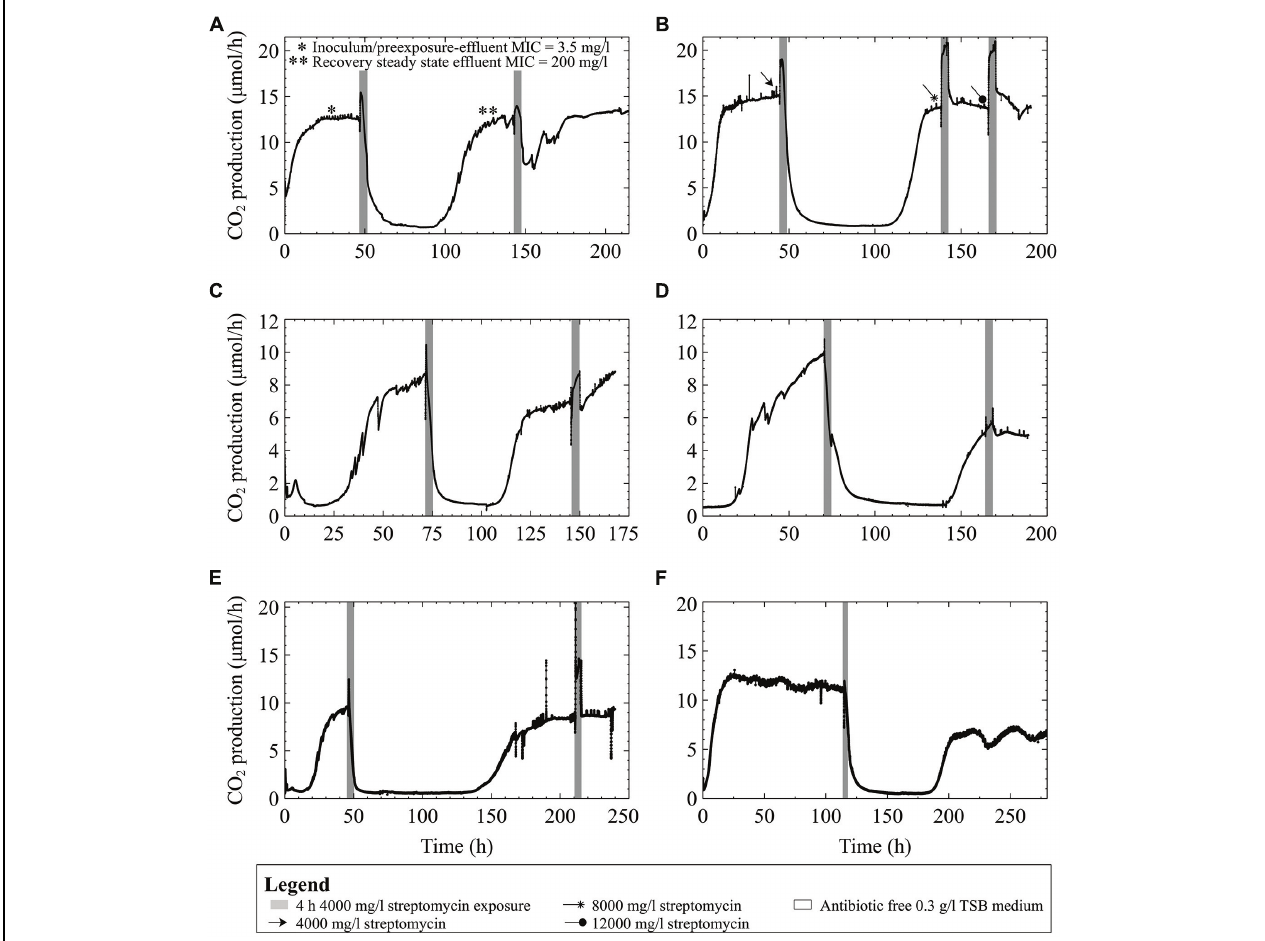
FIGURE 7 | CO 2 production ( µ mol/h) of biofilms inoculated from bench cultures exposed to streptomycin in 0.3 g/l TSB medium for 4-h intervals. (A) Multispecies culture grown on 0.3 g/l TSB medium and exposed to 4000 mg/l streptomycin. The effluent cell numbers decreased from 2.0 × 10 7 CFU/ml at steady state to 9.0 × 10 2 CFU/ml at the end of the first 4 h exposure. In contrast, the second exposure did not result in a similar decrease of effluent cell numbers; which were 2.4 × 10 5 CFU/ml at the end of the 4 h exposure (B) P. aeruginosa on 0.3 g/l TSB medium and exposed to either 4000, 8000, or 12,000 mg/l streptomycin